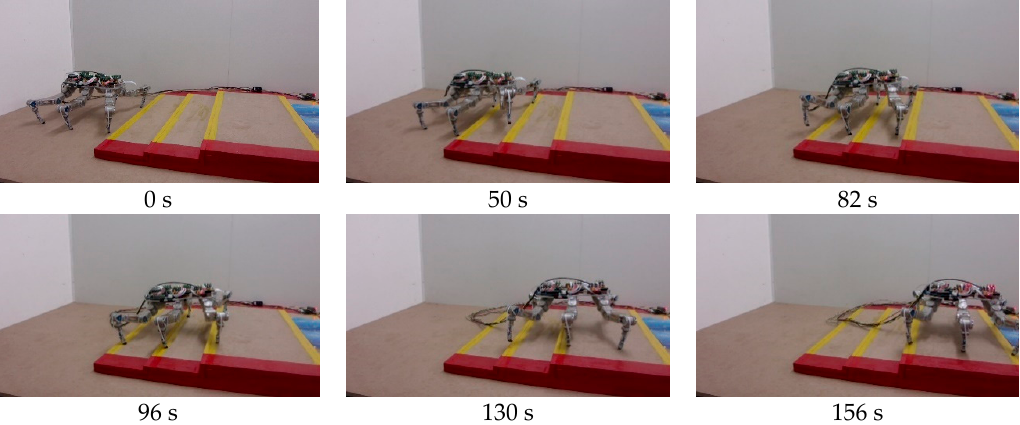
Figure 21. Process of stair climbing.